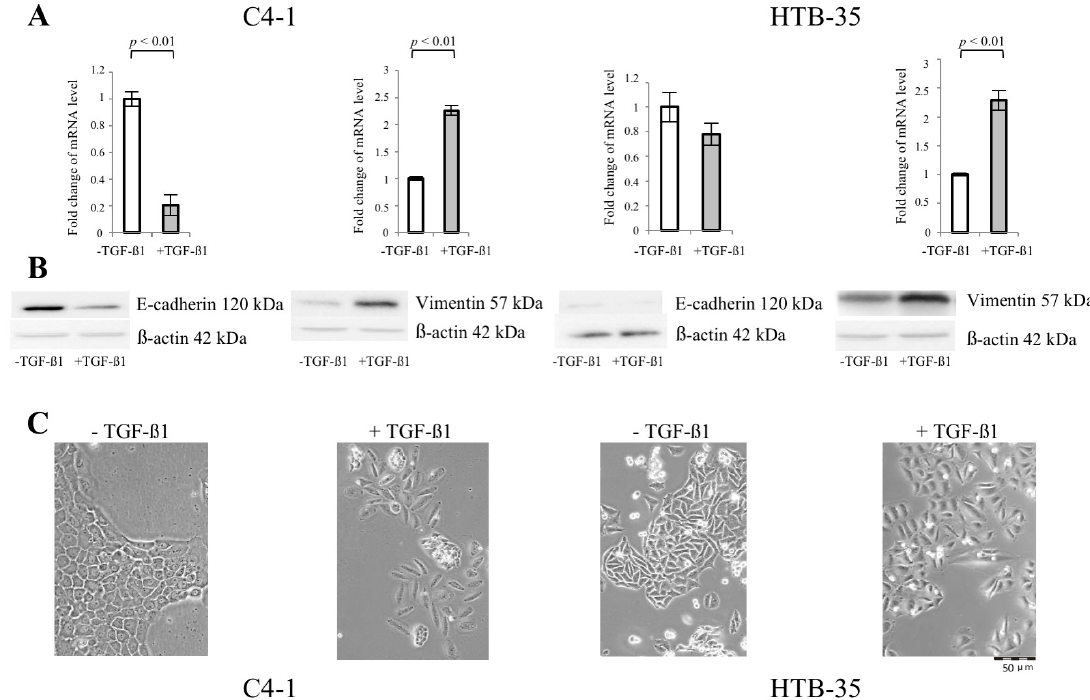
Figure 1. TGF- β 1 induces Epithelial-to-Mesenchymal Transition (EMT) in C4-I and HTB-35 cells ( A – C ).